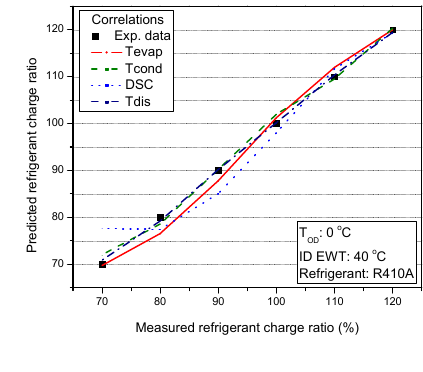
( a ) Comparison between experimental and predicted RCR at 𝐓 𝐎𝐃 of -5 ℃